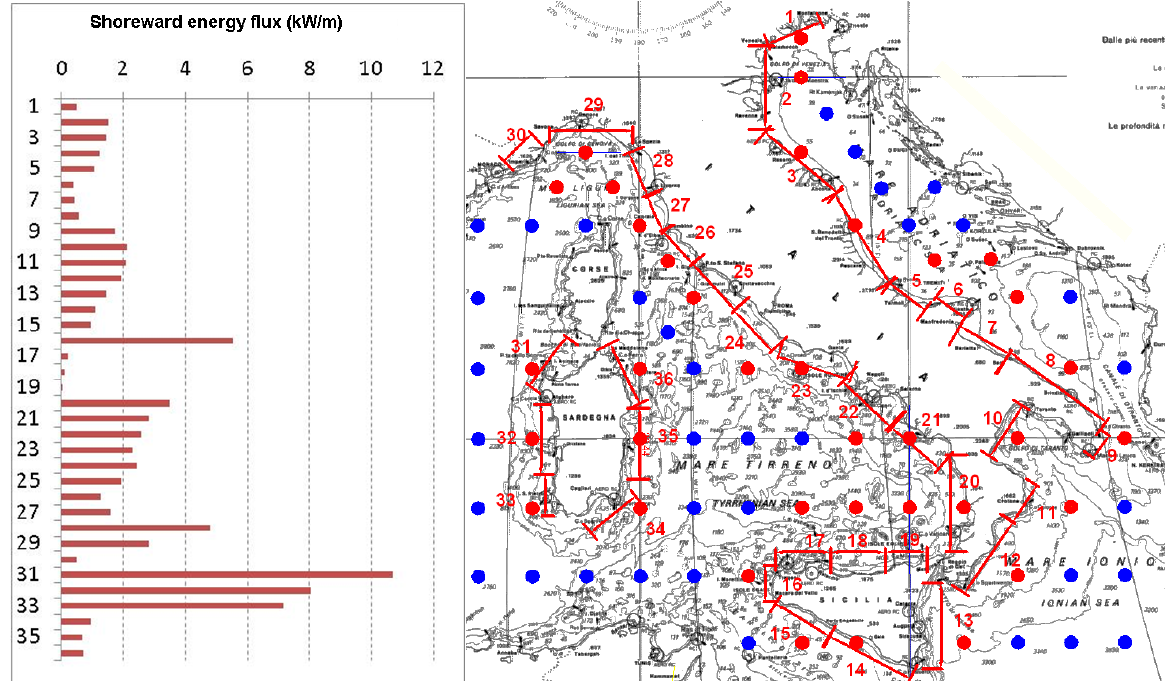
Figure 4. Position and numbering of the assumed segments around